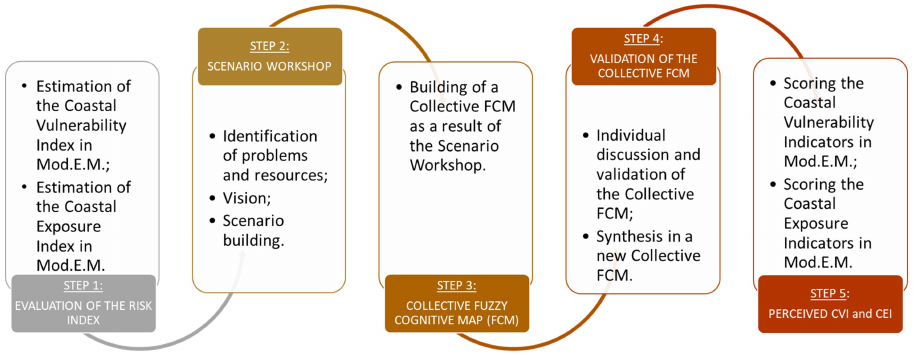
Figure 1. Integrated model for coastal risk